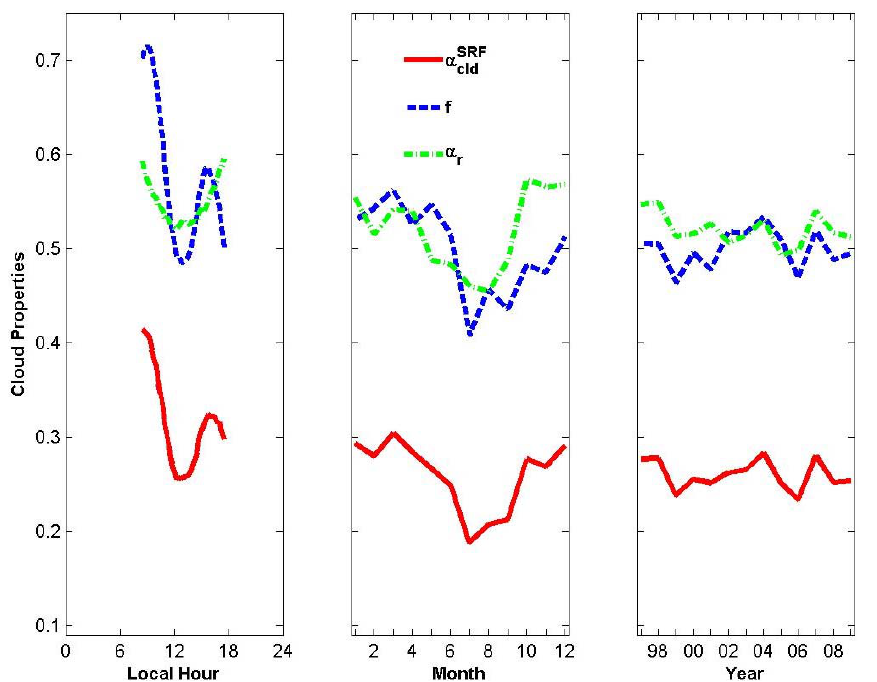
Fig. 11. Diurnal (left), annual (middle) and interannual (right) variations of the relative surface shortwave cloud radiative forcing (red), cloud fraction (blue) and cloud albedo